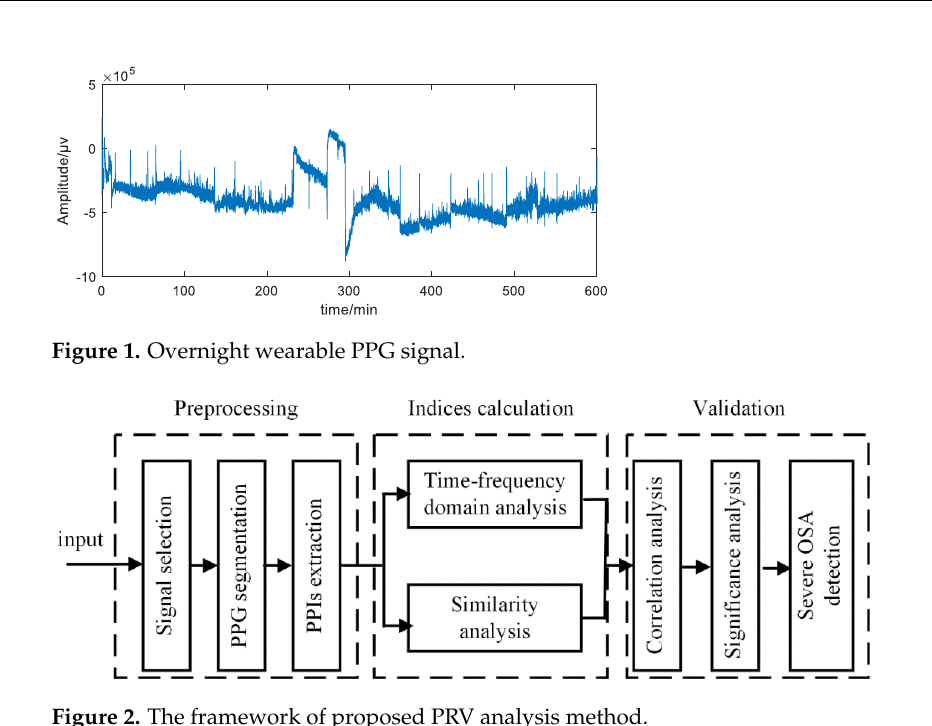
Figure 2. The framework of proposed PRV analysis method.